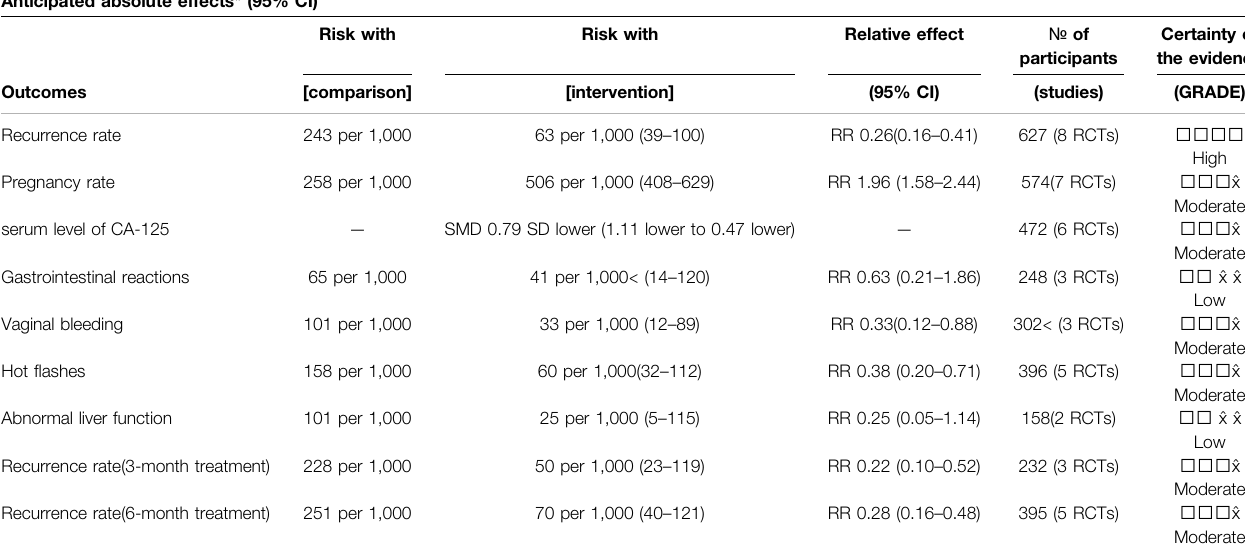
TABLE 2 | GRADE rating of the quality of each outcome. Anticipated absolute effects* (95%